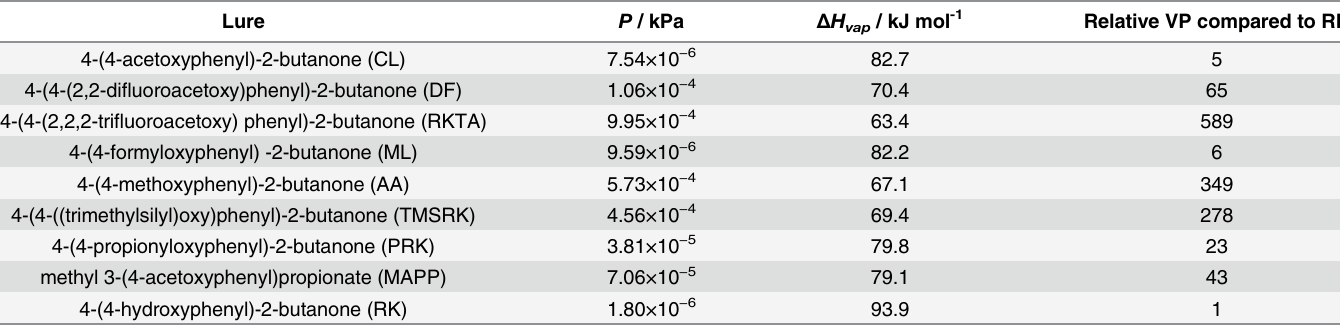
The values were calculated using the determined Antoine parameters. The relative vapour pressure (VP) compared to 4-(4-hydroxyphenyl)-2-butanone (RK) is